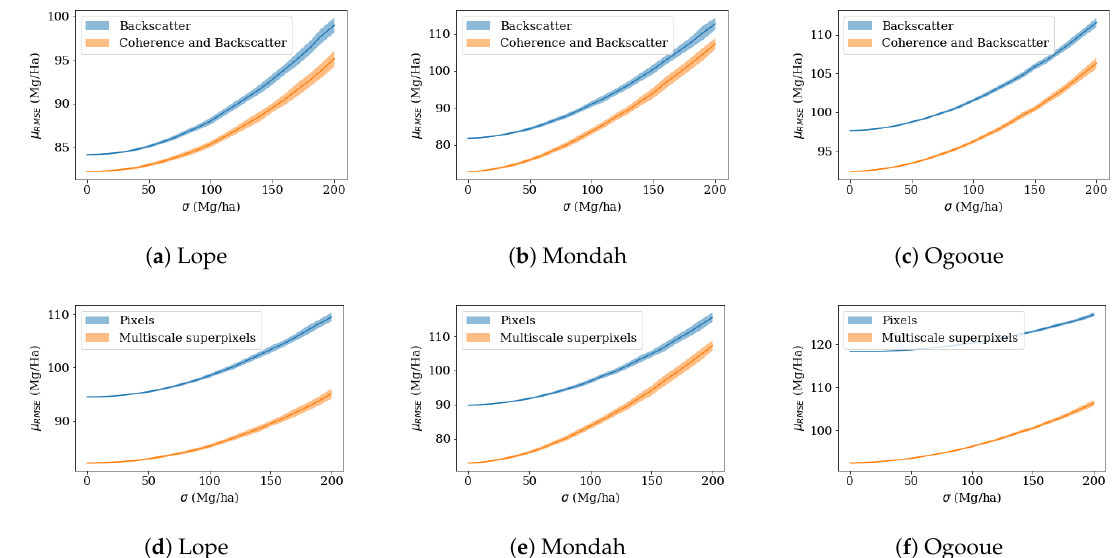
Figure 9. Mean RMSE of 100 models trained on different realizations of the additive noise model of Equation (1) with fixed σ in [ 0,200 ] over the three UAVSAR sites. The top row are the comparisons between AGB estimates using and excluding InSAR coherence; the bottom row is a comparison of models using the multiscale superpixel features with those models using only pixel-derived